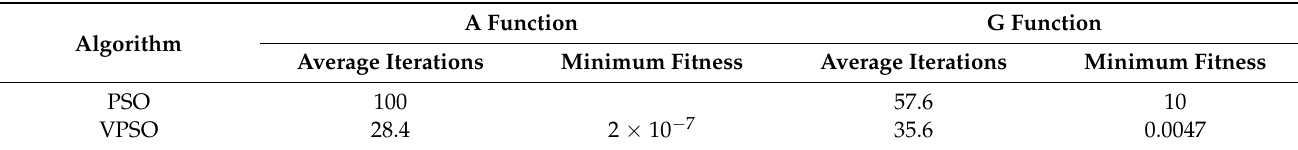
Figure 11. The minimum fitness curve of the two algorithms, PSO and VPSO, ( a ) The fitness variation of A function, ( b ) The fitness variation of G function. Table 3. The minimum fitness of the two